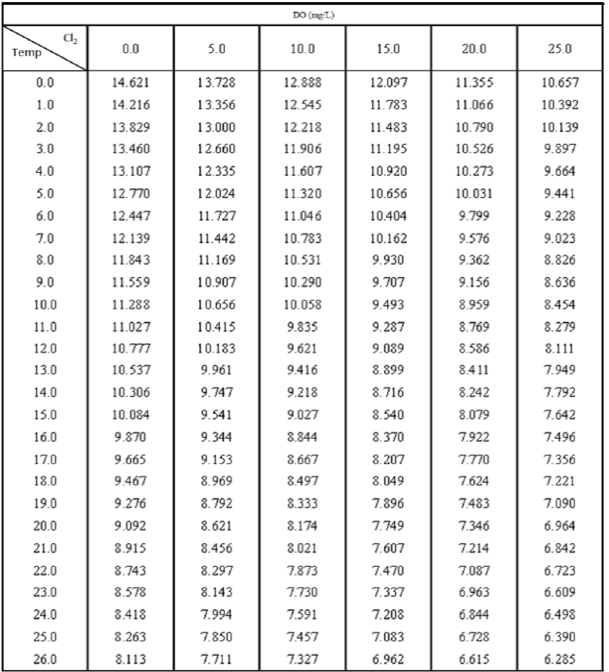
Figure 6. The Pt100 module.